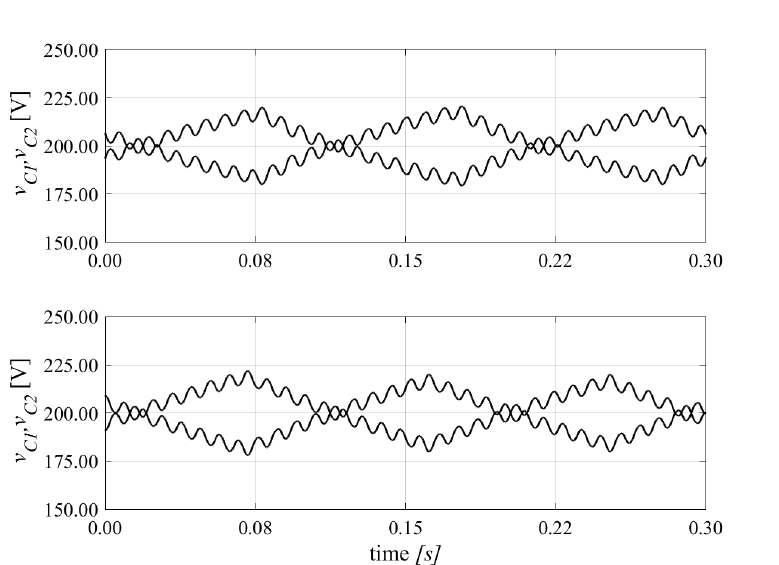
Figure 9. Numerical result: capacitors voltages for the traditional SVM (upper trace) and proposed one